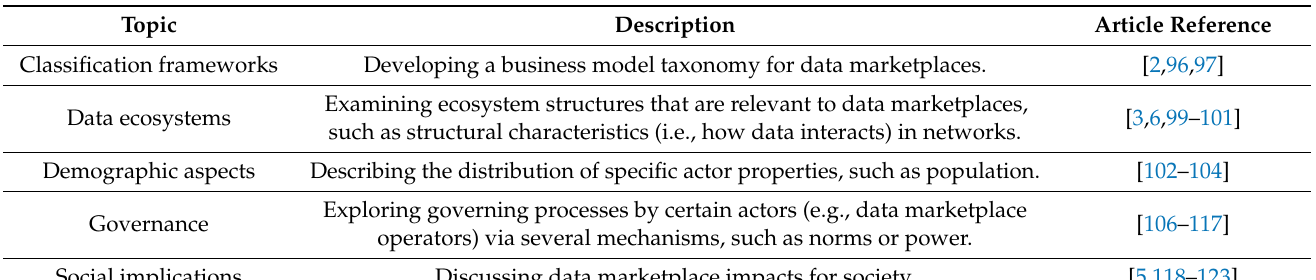
Table 4. The organization domain.